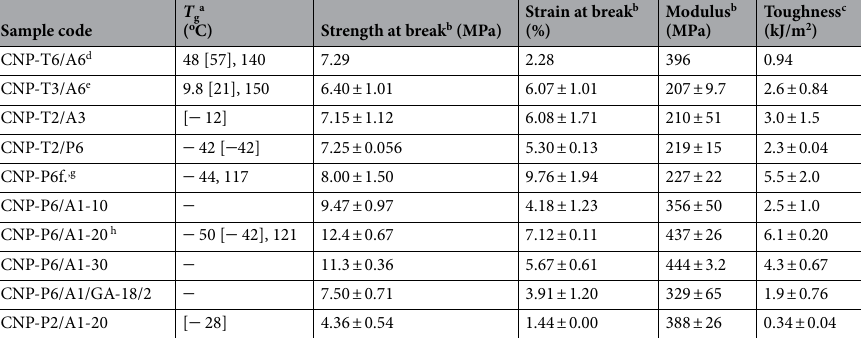
Table 2. Thermal and mechanical properties of the CNPs using M120G as the monolith sheet and acrylic thermosets as the second component. a Based on the tanδ peak temperature of DMA measured at a frequency of 1 Hz and a heating rate of 2 °C/min. Values in bracket indicate T g values for the bulk thermosets of the second component determined by DMA. b Based on the tensile test at the rate of 1 mm/min and room temperature. The modulus was determined in the strain range of 0.05–0.25% c Evaluated based on an area below each stress–strain curve. The toughness values of M120G was 4.4 ± 0.77 kJ/m 2 . d The E’ values of CNP- T6/A6 were 1680, 309, and 8.9 MPa at 25, 100, and 180 °C, respectively, determined by DMA. e The E’ values of CNP-T3/A6 were 240 and 17.5 MPa at 80 and 180 °C, respectively, determined by DMA. f M120A was used instead of M120G. g The E’ values of CNP-P6 were 3170, 324, and 23.1 MPa at ‒ 80, 0, and 160 °C, respectively, determined by DMA. h The E’ values of CNP-P6/A1-20 were 5530, 839, and 29.6 MPa at ‒ 80, 0, and 160 °C, respectively, determined by